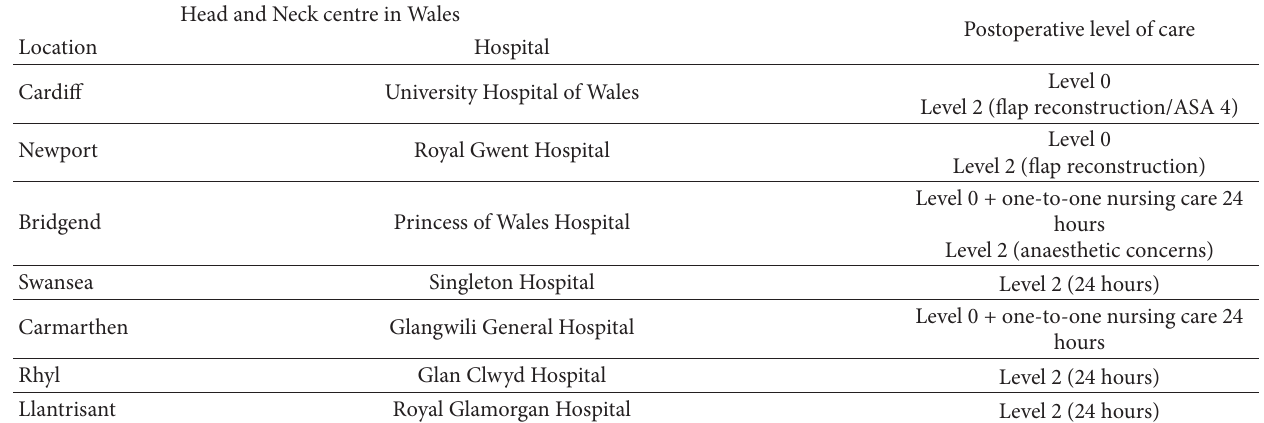
Table 4: Variation of postoperative discharge destination across Head and Neck centres in